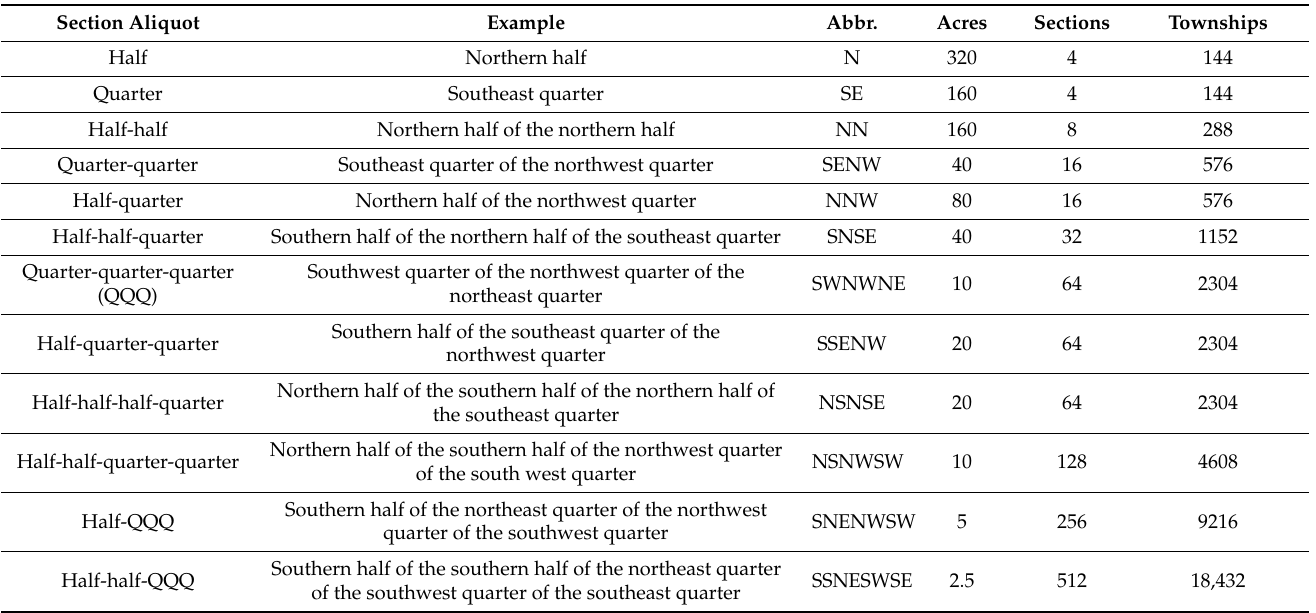
Table 1. Possible aliquots within a section, size of each aliquot, and count per section and township.